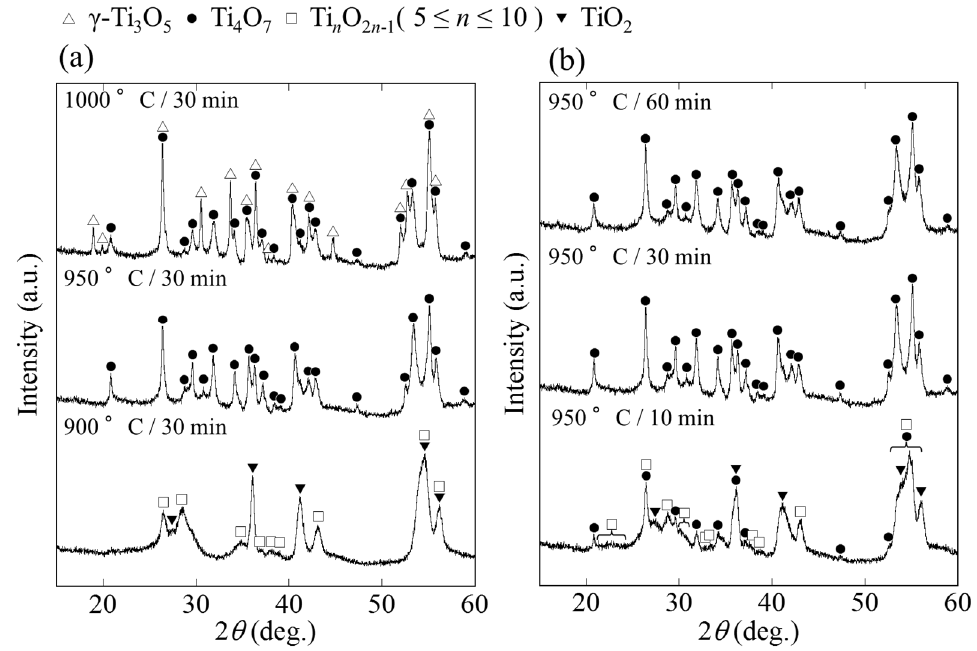
Figure 2. X-ray diffraction patterns of the samples synthesized by conventional heating at various heating temperatures ( a ) and times ( b ).